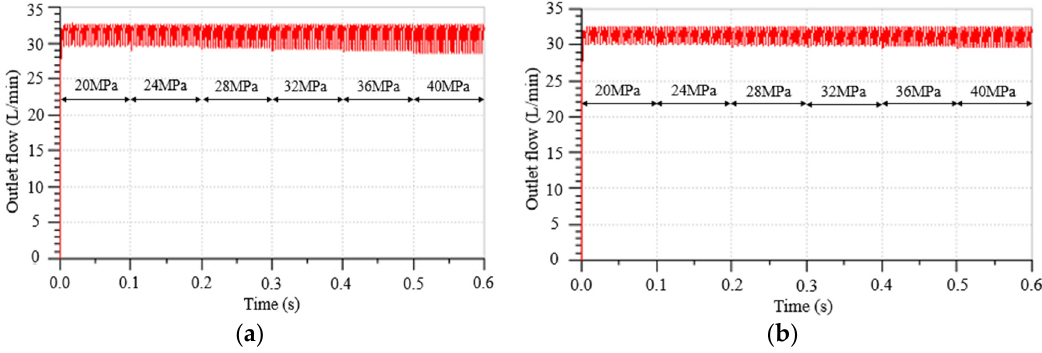
Figure 8. Flow characteristic curves of the pump: ( a ) Before optimization; ( b ) After optimization.